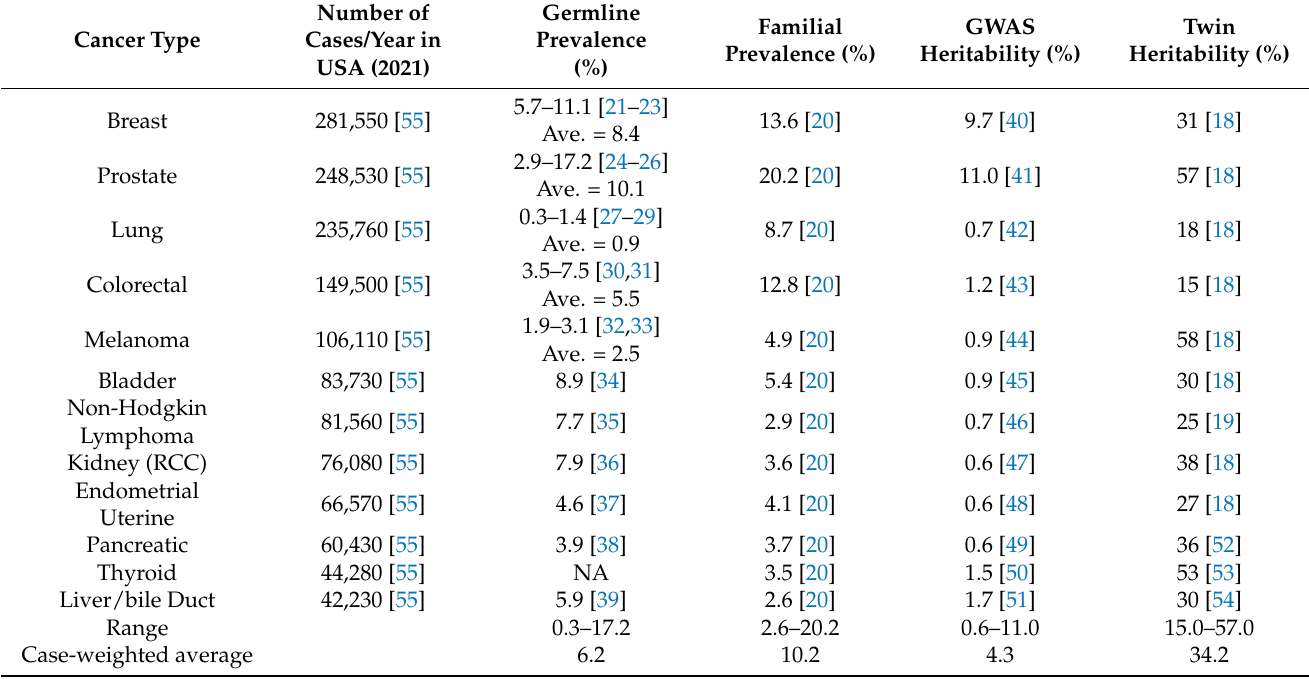
Table 1. The genetic contributions to cancer. Prevalence of heritable cancers as compared with the estimated heritability of